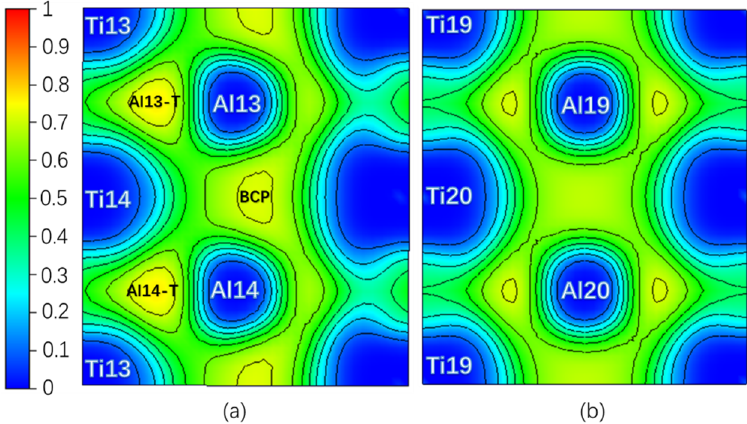
Figure 2. (Color on line.) ( a ) Electron Localization Function (ELF) on Layer7, the maximum value is 0.765; ( b ) ELF on Layer10, the maximum value is 0.715 in pure twin. Al13-T and Al4-T are three-center bonds. Table 1. Properties of ELF and Quantum Theory of Atoms in Molecules (QTAIM) at non-nuclear maxima (NNM) of the three-center region and bond critical points (BCP) on Layer7 at 0 shear displacement under pure and interstitial atom